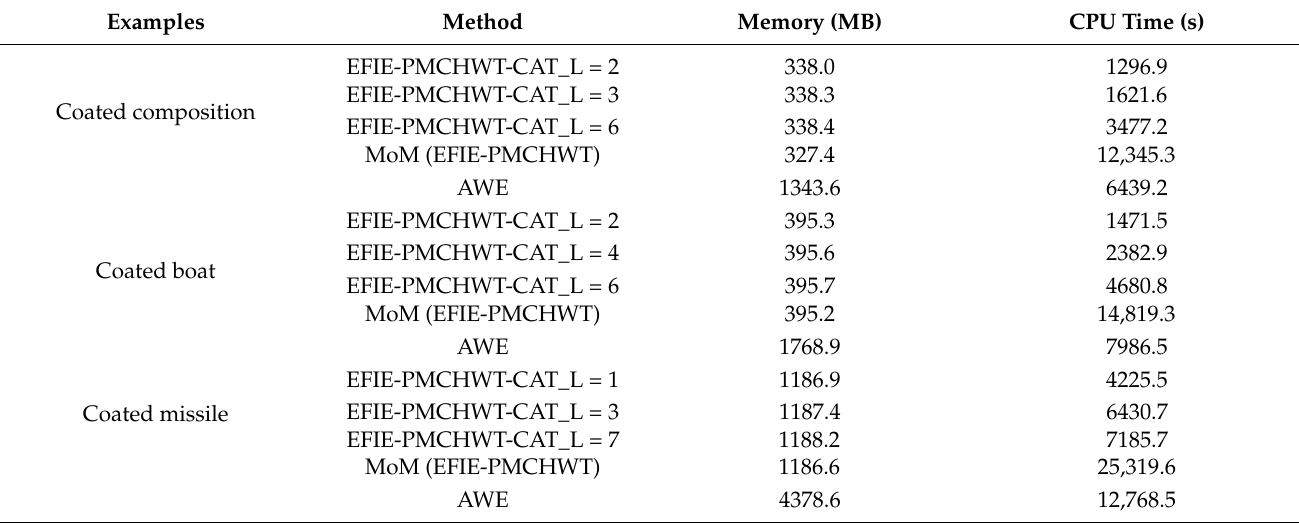
Table 1. The total CPU time and memory requirement of three